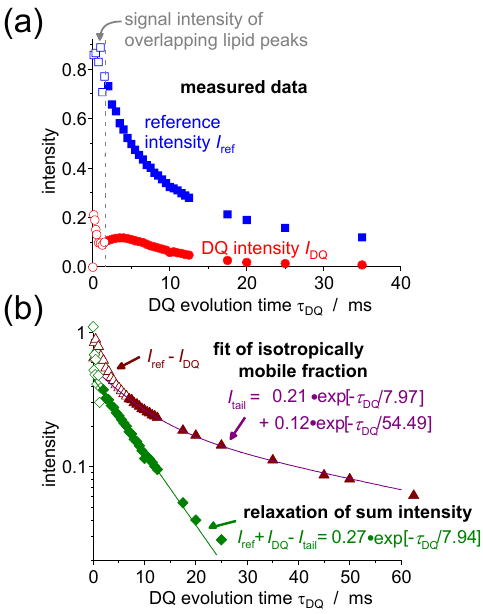
Figure 16. Results from a DQ experiment on DMPC/GP 60:1 at 40 ◦ C. ( a ) Measured DQ and reference intensities; ( b ) tail fraction determined from the difference intensity to be the sum of two exponentials, and single-exponential fit of the sum intensity; ( c ) normalized DQ build-up curve and results from a fit based upon Equation